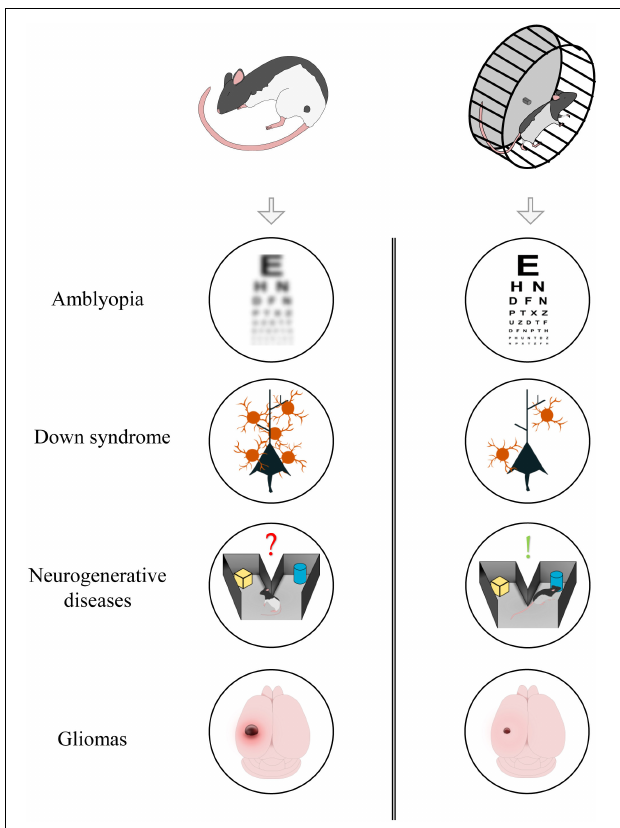
FIGURE 1 | Aerobic exercise could exert beneficial effects in different forms of neuropathology. From top to bottom: exercise induces visual recovery in adult amblyopic subjects; it reduces GABAergic innervation in animal model of Down Syndrome; it improves memory formation and consolidation in neurodegenerative diseases; it contributes in reducing tumoral mass in glioma-bearing